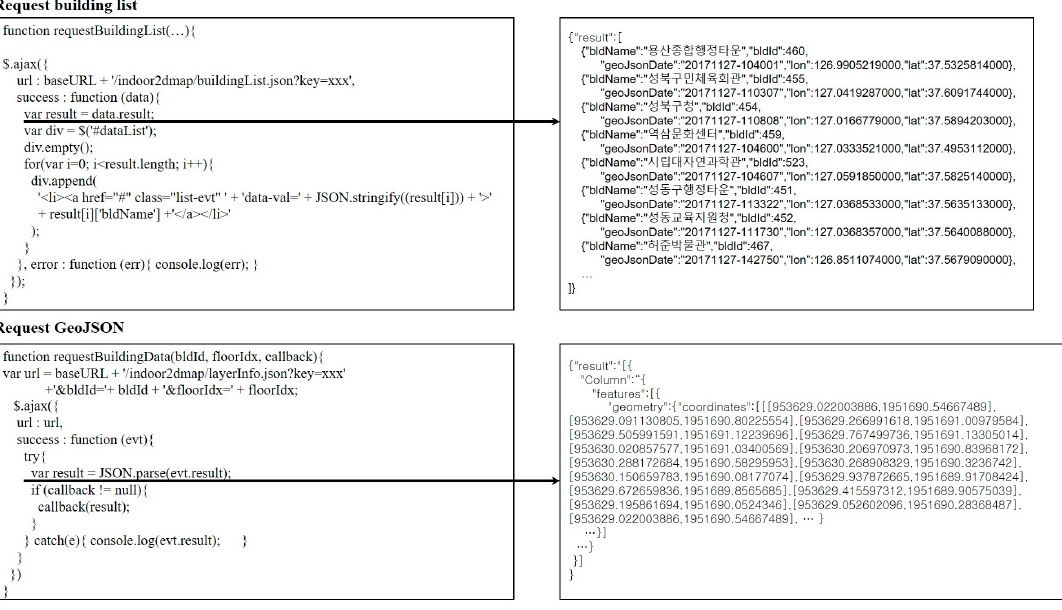
Figure 9. Application examples of requests by JavaScript and their responses based on Open API and GeoJSON.